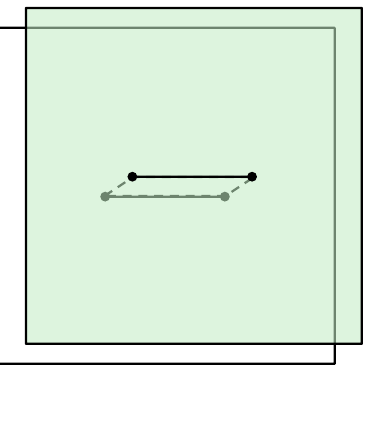
Figure 2. Illustration of the replica calculation of Renyi entropy in (cid:12)xed background (eq. (2.5)) for n = 2. The replica geometry has conical singularity at the branch